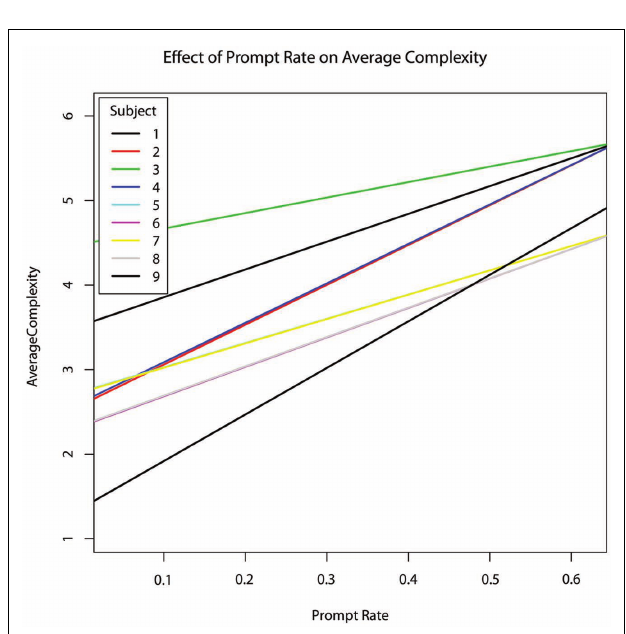
FIGURE 6 |The effect of prompt rate per second within each session on average choice complexity within each session, controlling for age. Both prompt rate and average complexity increased across sessions.